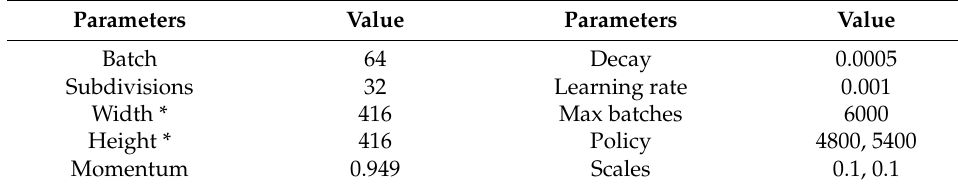
Table 2. Parameters of YOLO model training.